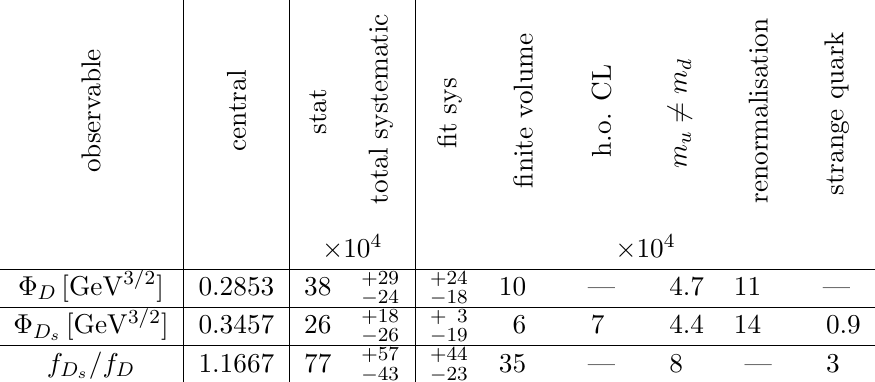
and the ratio of s